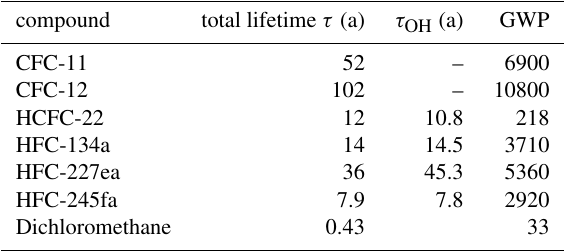
Table 1. Atmospheric lifetimes of CFCs, HCFCs, HFCs (SPARC, 2013), and dichloromethane (Hossaini et al., 2017) and global warming potentials (GWP) (IPCC, 2013) of the discussed species.